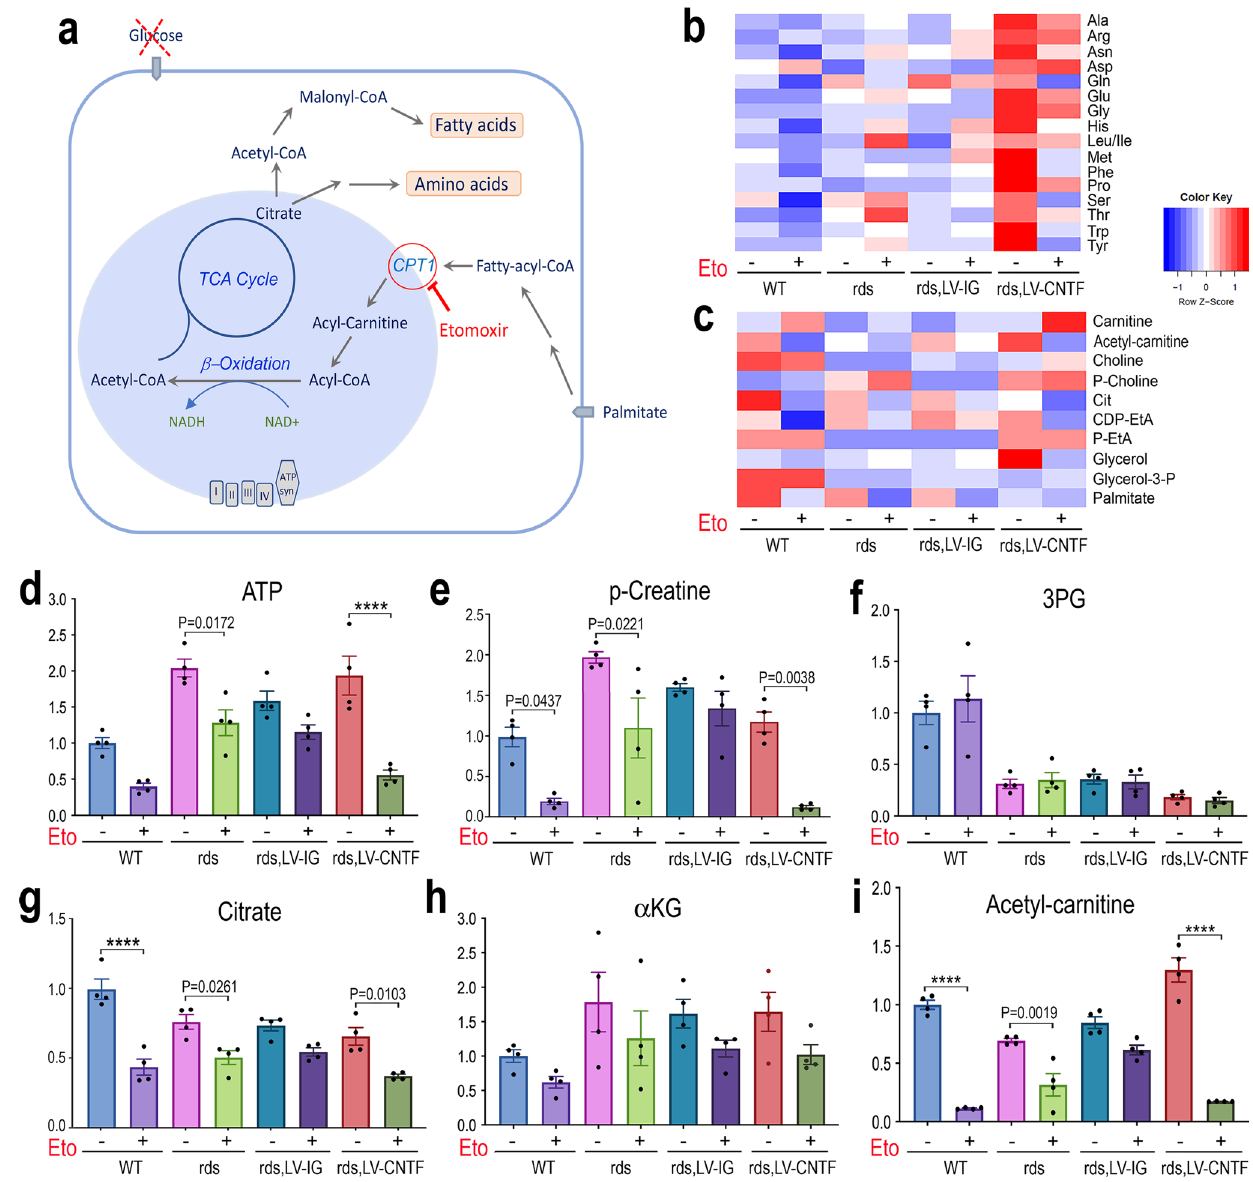
Fig. 8 | Consumption of fatty acid fuel by wild type and rds mutant retinas. a Schematic illustration of fatty acid metabolic pathways and Cpt1 as a target of inhibitor Etomoxir. b , c Metabolomics heatmaps show the effects of Etomoxir on levelsof b amino acids and c fatty acid synthesisintermediates in WT, rds, and rds retinas treated with LV-IG or LV-CNTF from P28-P53. d – i Bar graphs show the effects of Etomoxir onlevels of ATP ( d ),p-creatine ( e ),3PG( f ),citrate ( g ), α KG( h ),